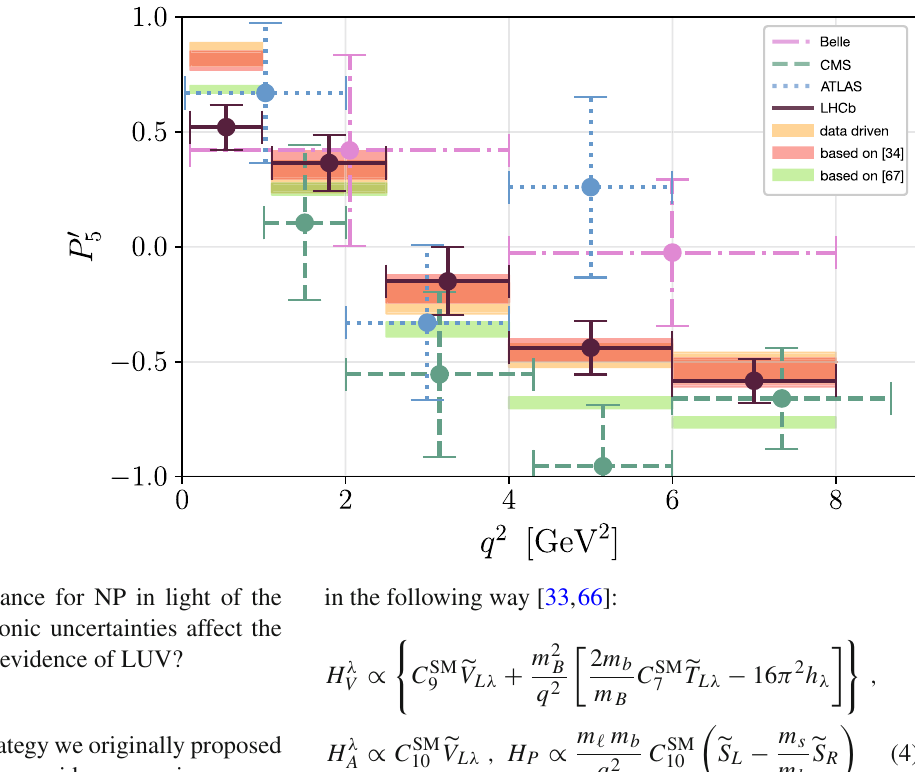
Fig. 2 The result for the optimized observable P (cid:8) Ref. [73]) from a global fit within the SM in three different approaches for the charming penguin contribution, compared to experimental data. Only the approach fully relying on LCSR estimates (Refs. [71,72]) and their extension by means of dispersion relations in the entire dilepton invariant-mass range may lead to the so-called “ P (cid:8)